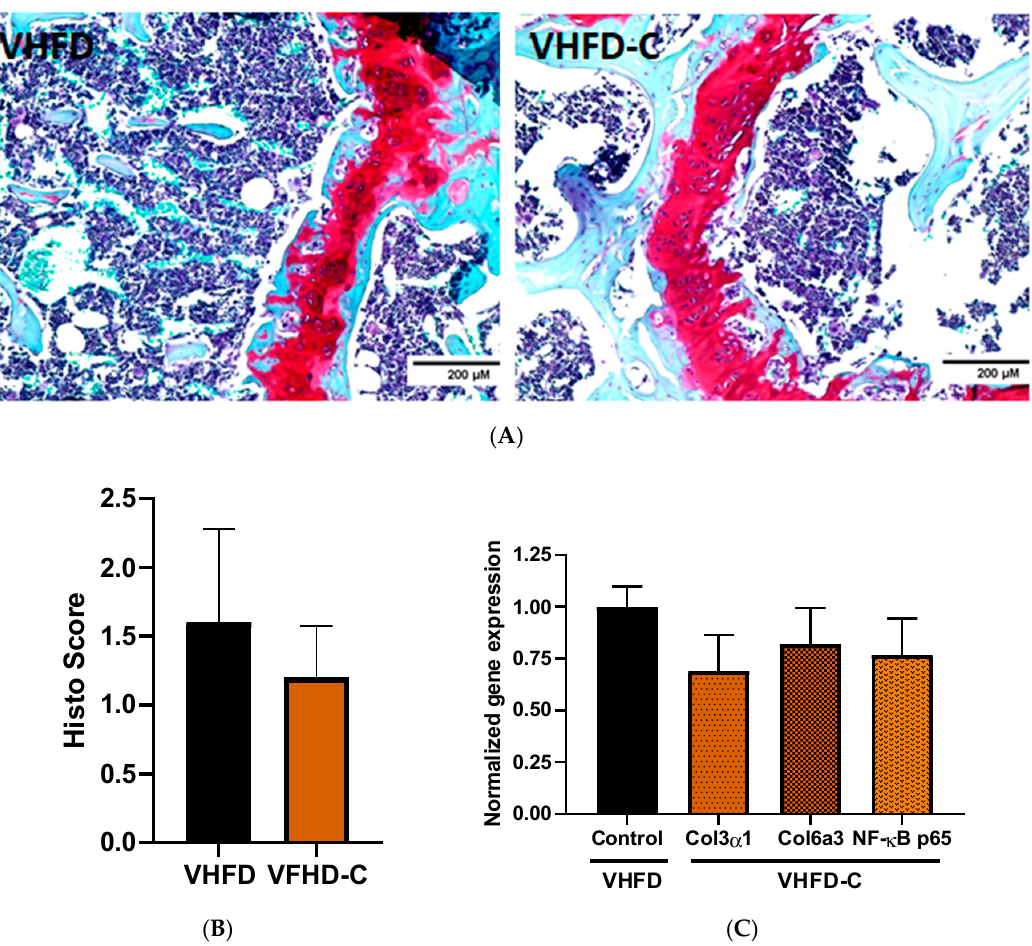
Figure 7. Effects of curcumin on mouse knee cartilage integrity. ( A ) Photomicrograph of mouse joint. Cartilage is shown red on the image. Representative images of Safranin O with the counterstain and H&E stained sections. Cartilage—crimson; collagen—green/blue; nuclei—black. Magnification 200 ×; n = 5. ( B ) Cartilage loss severity score. ( C ) Cartilage gene expression in curcumin-fed animals compared to control group. Target gene expression is normalized to TATA box binding protein gene. p value 0.241, 0.490 and 0.381 respectively; n = 5–6.